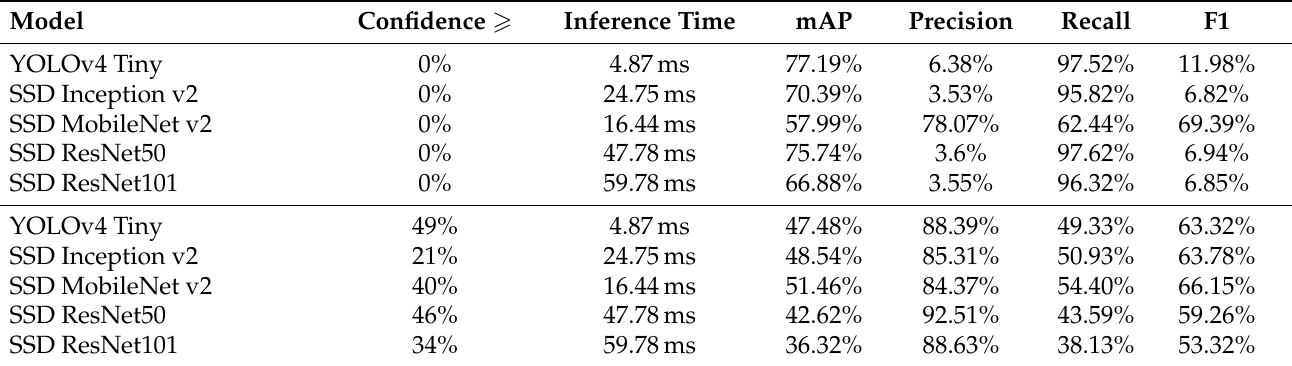
Table 5. Results of the different SSD and YOLO models over many metrics, considering all the predictions and the best computed confidence